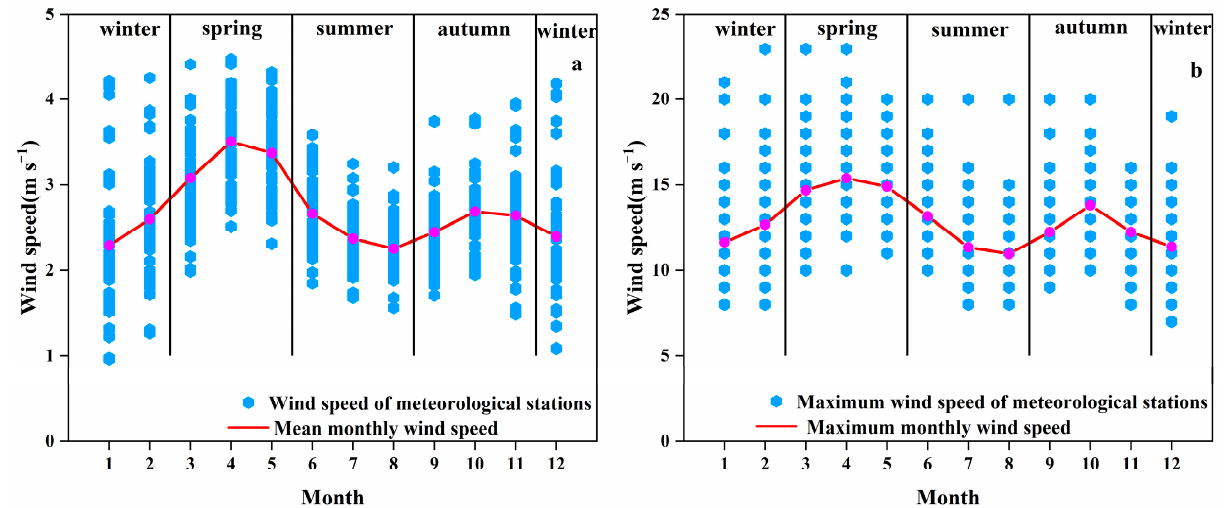
Int. J. Environ. Res. Public Health 2022 , 19 , x FOR PEER REVIEW Figure 6. Seasonal variation of wind speed in water erosion area of the typical black soil region. (( a ): mean monthly wind speed, ( b ): maximum monthly wind speed).